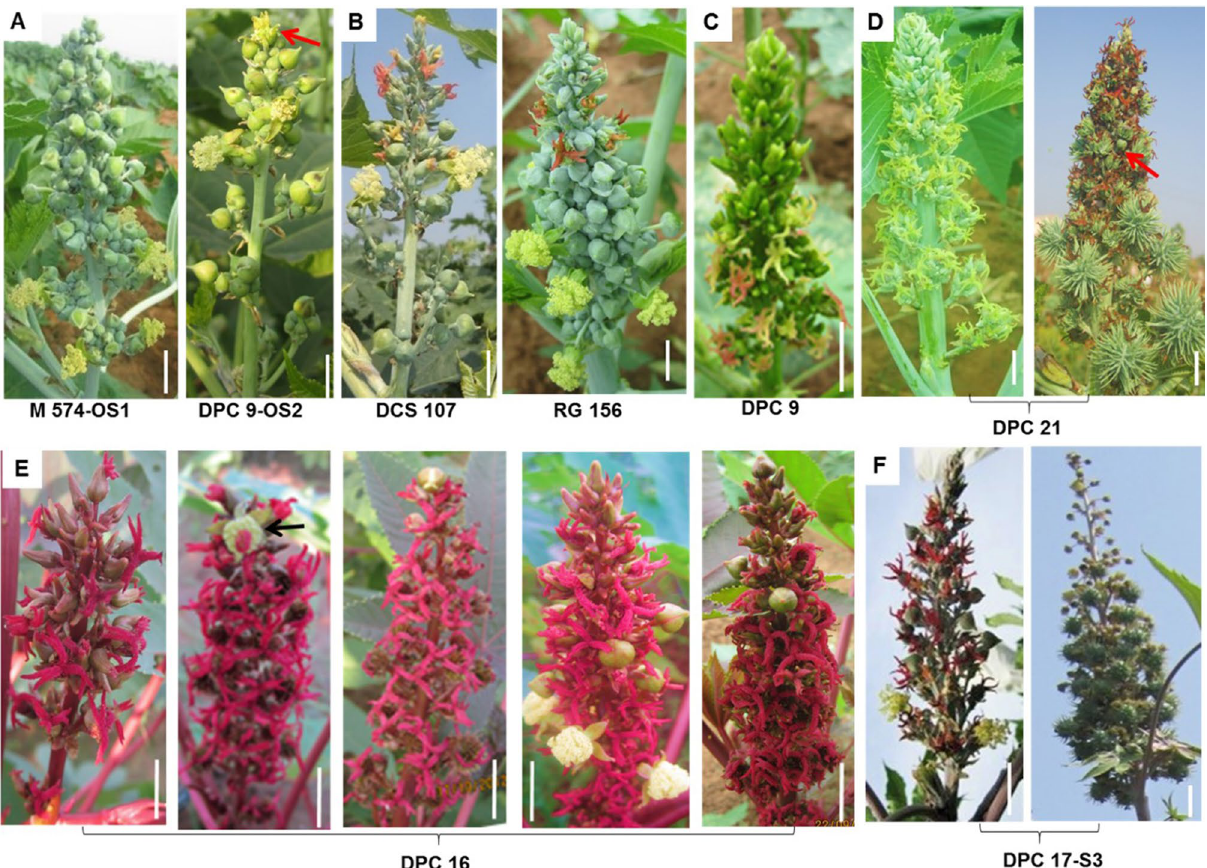
Figure 1. Sex variability in castor genotypes. Inflorescences which are ( A ) Predominantly male (above quarternary branching orders) with terminal bisexual flower. ( B ) Monoecious with 30–50% male flowers (DCS 107) and 70–80% male flowers (RG 156) ( C ) Completely pistillate. ( D ) Interspersed staminate flowers (ISF) at capsule maturation. ( E ) Completely pistillate predominantly pistillate with single terminal hermaphrodite flower, few hermaphrodite flowers, male flowers at random positions and terminal female or male flower and ( F ) Apical ISF. Genotype names are indicated below. Scale bar: 1 genotypes also differed in inflorescence architecture. In DCS 107, the female flower bud appeared with in first to third whorl from bottom (Fig. 2B), whereas in RG 156, not a single female bud was observed in lower whorls (Fig. 2C). In pistillate lines DPC 9 and DPC 21, female buds alone were seen in all the whorls, although male flowers were observed during sex reversion or ISF in DPC 9 and capsule formation (ISF) in DPC 21. In M 574- OS1, only male flowers were observed from quaternary orders but the terminal flower was occasionally bisexual in some spikes. In DPC 17-S3 (with apical ISF spike), male flowers were found throughout the inflorescence, but completely female whorls occurred occasionally in between (Supplementary Table S3). In top whorls with triplet buds, one of the two lateral buds were male and the terminal bud was mostly female. Also, few slightly pointed male flowers towards the spike tip were observed in DPC 17-S3 and DCS 107, while some female flowers of RG 156 and DPC 9 were round than elongated (Supplementary Fig. S4), which were more prominent during summer. For a given length, the number of floral whorls decreased with branch order (tertiaries had less whorls than secondaries). Every spike order in a genotype had definite number of floral whorls during emergence which did not increase significantly later, but increase in floral whorls during inflorescence elongation and develop- ment was noticed in monoecious DCS 107 and staminate M 574-OS1 (p < 0.05) (Supplementary Table S3; Sup- plementary Fig. S5) indicating potential of sex lability with environmental conditions during growing season in these genotypes. The number of flowers in a floral whorl (especially in lower whorls) may increase, due to continuous development of flower primordia in triplets, resulting in more branching. Apical meristem shows chronology of organ developmental stages during inflorescence initia- tion and development. Inflorescence primordia initiation at stage I, though not distinct externally and inflorescence development at stage II were identified by histology sections and SEM. The much-condensed inter- nodes near apical meristem, enveloped by bracts were revealed only after emergence of each leaf at a node, which takes approximately 3–4 days. Inflorescence primordia initation usually occurs at 8-12 nodes in the primary branch or later depending on genotype, growth conditions and seed quality (data not shown). Fully emerged inflorescence (stage V) appeared 3–5 nodes later than or 2–3 weeks after inflorescence initiation at stage I.